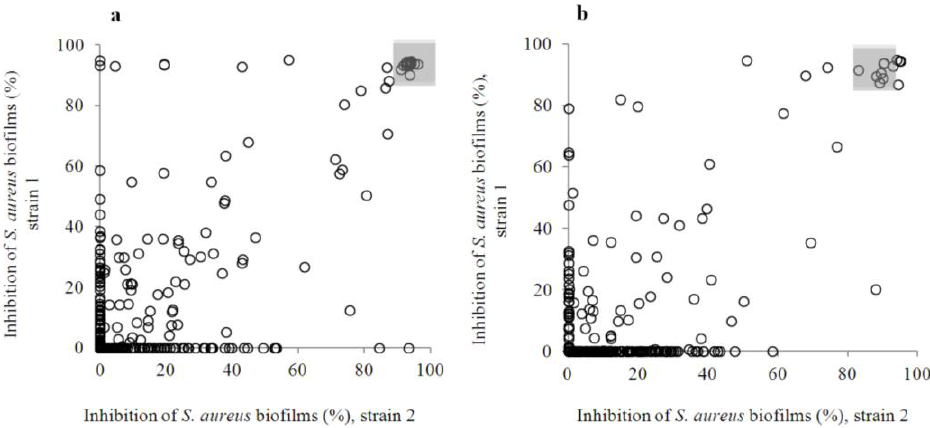
Figure 2. Anti-biofilm effects of the flavonoids collection when added prior-to ( a ) or post-biofilm formation ( b ). Strains 1 and 2 are S. aureus ATCC 25923 and Newman clinical strains, respectively. Highly active flavonoids are those present in both shadowed areas. Primary screening results are presented in Table